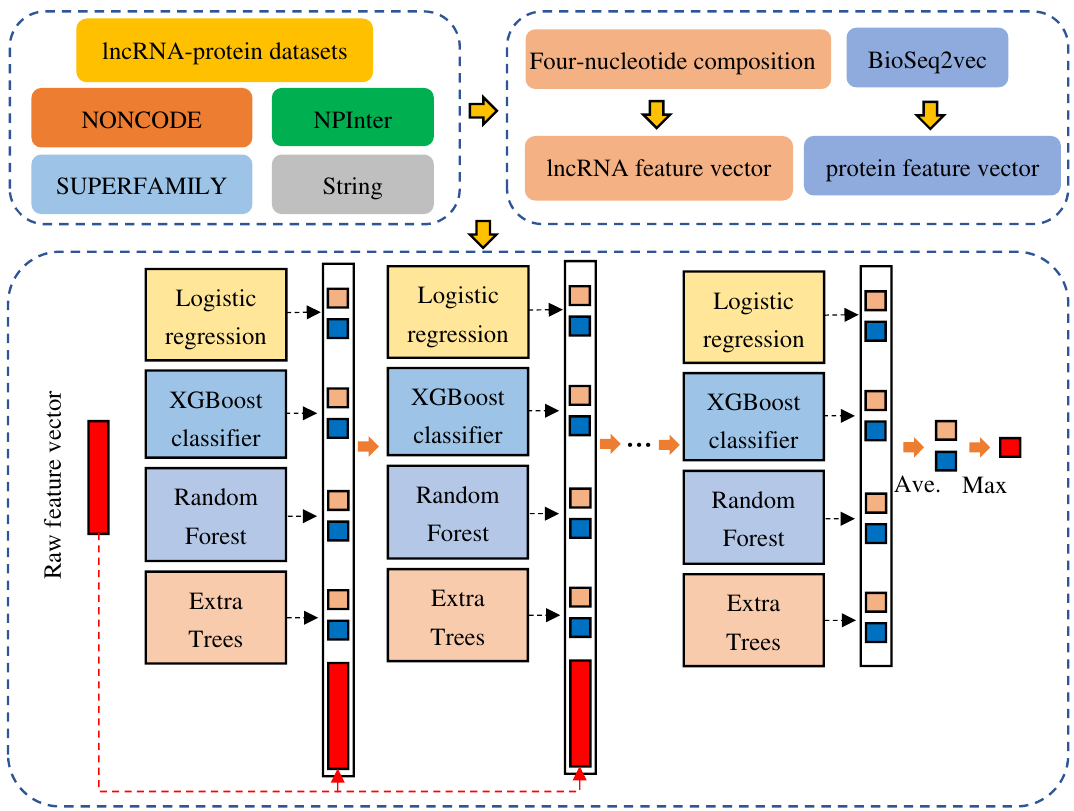
Figure 5. Flowchart of the LPI prediction framework based on deep forest with cascade forest